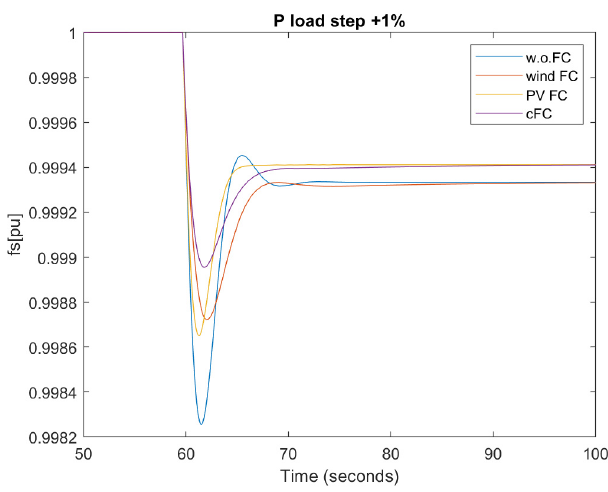
Figure 10. Simulation 1 frequency trend.